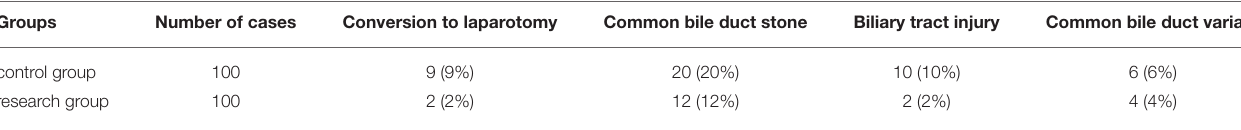
TABLE 2 | Comparison of intraoperative conditions between the two groups (%).